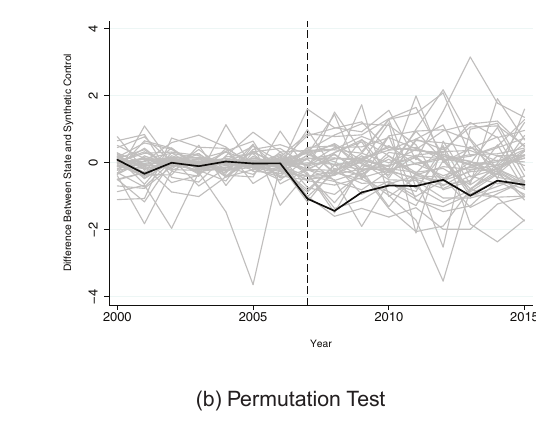
Figure A22 Native low-skilled male weekly hours (hours > 0)